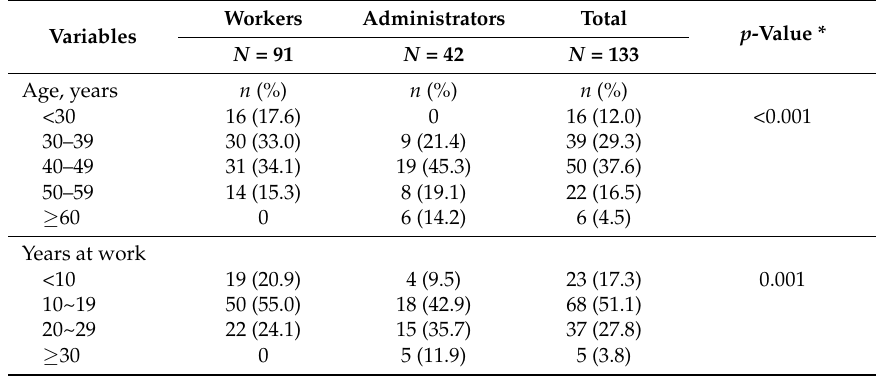
Table 1. Demographic and lifestyle characteristics of workers exposed to antimony and administrative staff.